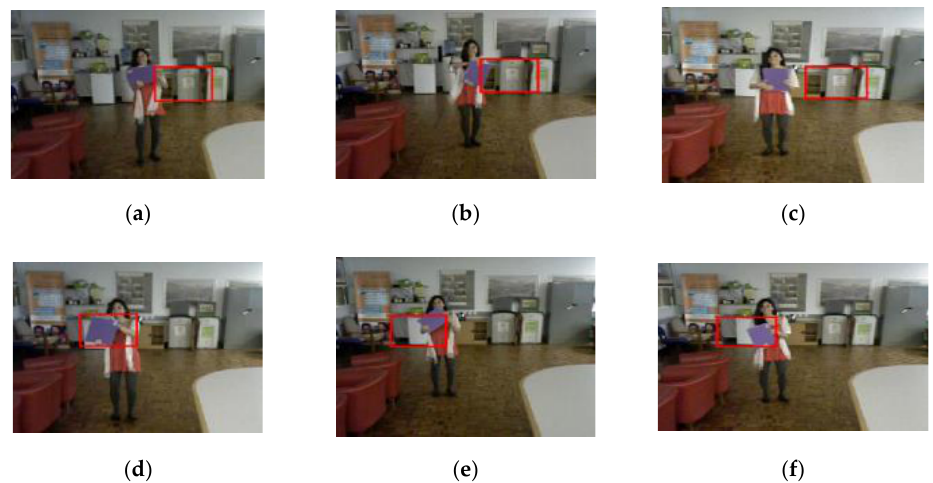
Figure 11. Comparison of original SiamFC and our convolutional block optimization-based SiamFC in scene “Book”: ( a – c ) Snapshots from original SiamFC (Precision: 9.14, AUPC: 2.85, IOU: 12.12,